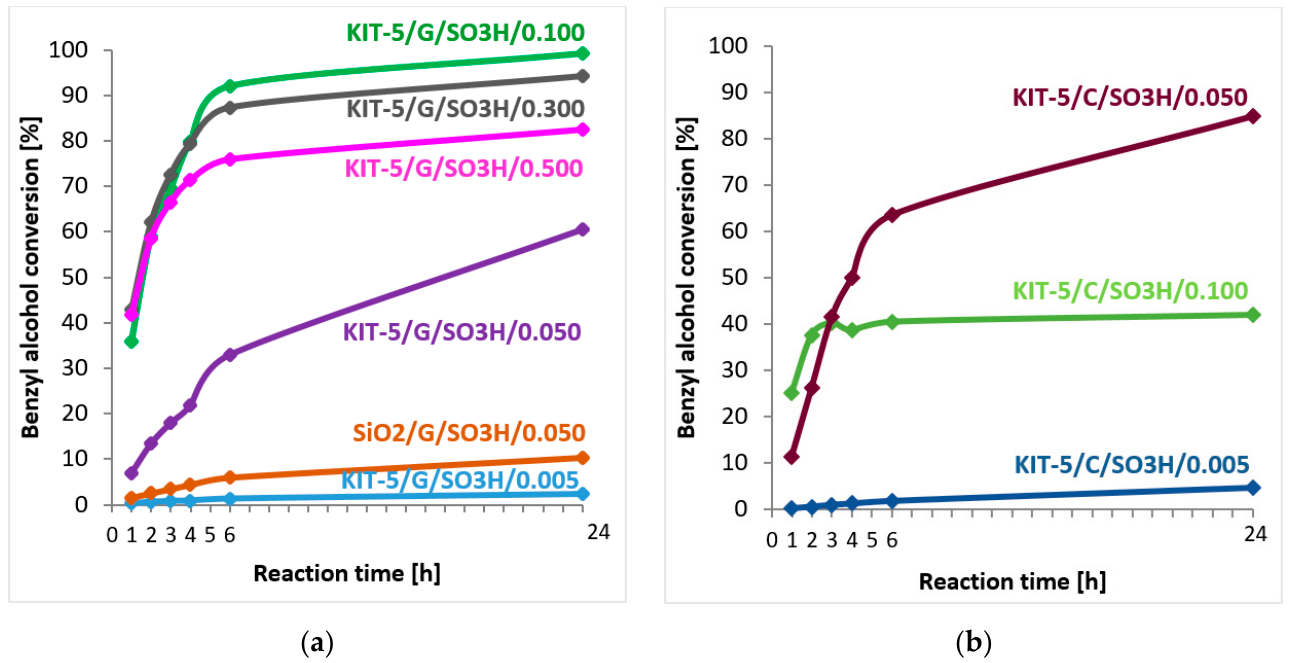
Figure 6. Relationship of benzyl alcohol conversion to the time of Friedel–Crafts alkylation reaction for KIT-5 type materials modified with sulfonic groups by ( a ) grafting or ( b ) co-condensation. Friedel–Crafts alkylation with commercial silica (SiO 2 ) modified with sulfonic groups was carried out analogously to the catalytic tests with KIT-5 materials. Thiol groups were introduced onto the SiO 2 surface by grafting MPTMS in the amount that corresponded to the volume of this precursor taken during preparation of KIT-5/G/SO 3 H/0.050 sample. Thus, an equivalent of this catalyst was obtained based on commercial silica with disordered arrangement of pores. The results of the catalytic tests show that conversion of benzyl alcohol for SiO2/G/SO 3 H/0.050 catalyst after the 1st hour of the reaction reached only 2%, and after the 6th and 24th hour of the reaction it was 6% and 10%, respectively. The results obtained for the analogous KIT-5/G/SO 3 H/0.050 material show that the catalyst with mesoporous structure is much more active than its counterpart based on the commercial silica, leading to much higher benzyl alcohol conversion (Figure 6). Therefore, it may be concluded that the ordered 3D mesoporous structure of KIT-5 material facilitates reagents distribution in the porous system. The selectivity values presented in Table 5 for individual products of the reaction